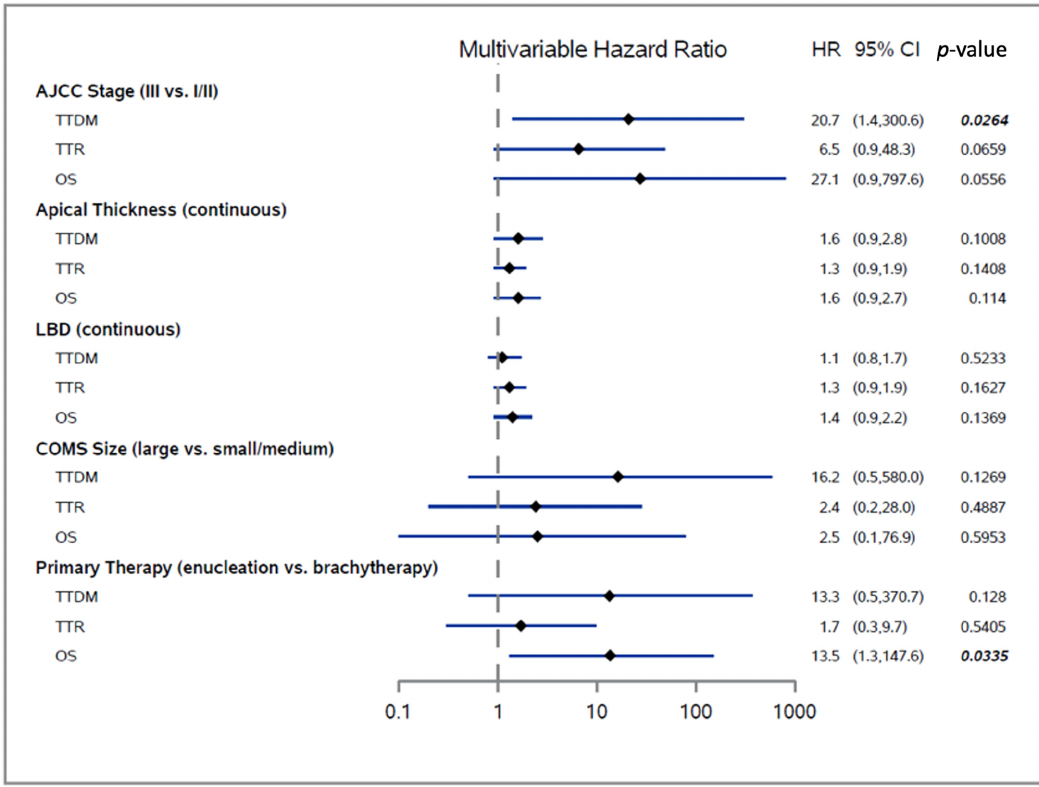
Figure 4. Forest plot of TTDM, TTR, and OS. Significant p -values are shown in bold and italic. Abbreviations: TTDM, Time to distant metastasis; TTR, Time to local or distant recurrence; OS, Overall survival; HR, Hazard ratio; CI, Confidence interval. Table 2. Univariable analysis of outcomes.